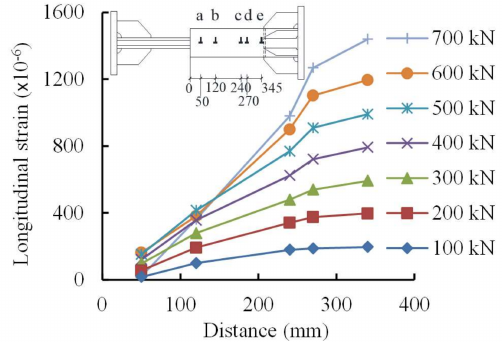
Figure 11. Longitudinal strains of sleeve for Specimen RT350.